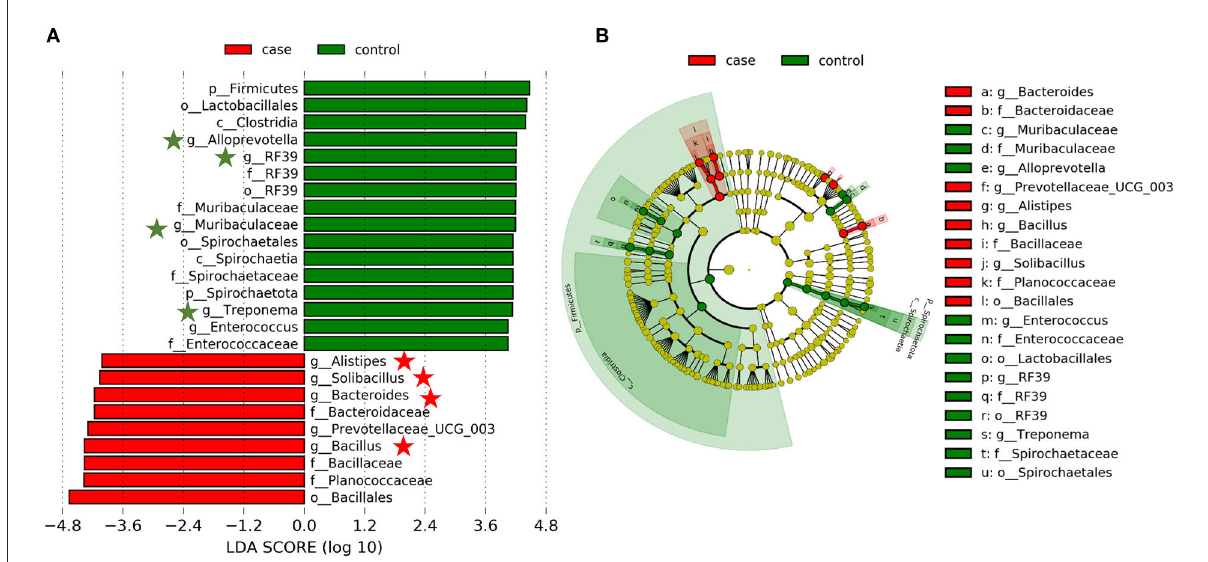
FIGURE4 Linear discriminant analysis effect size (LEfSe) analysis and linear discriminant analysis (LDA) characterized the gut microbiota. (A) LDA scores indicated differences in abundance between the case and control groups (LDA scores > 4.0). (B) Cladogram using LEfSe method revealed the phylogenetic distribution of gut bacterial community associated with the case (red) and control (green)